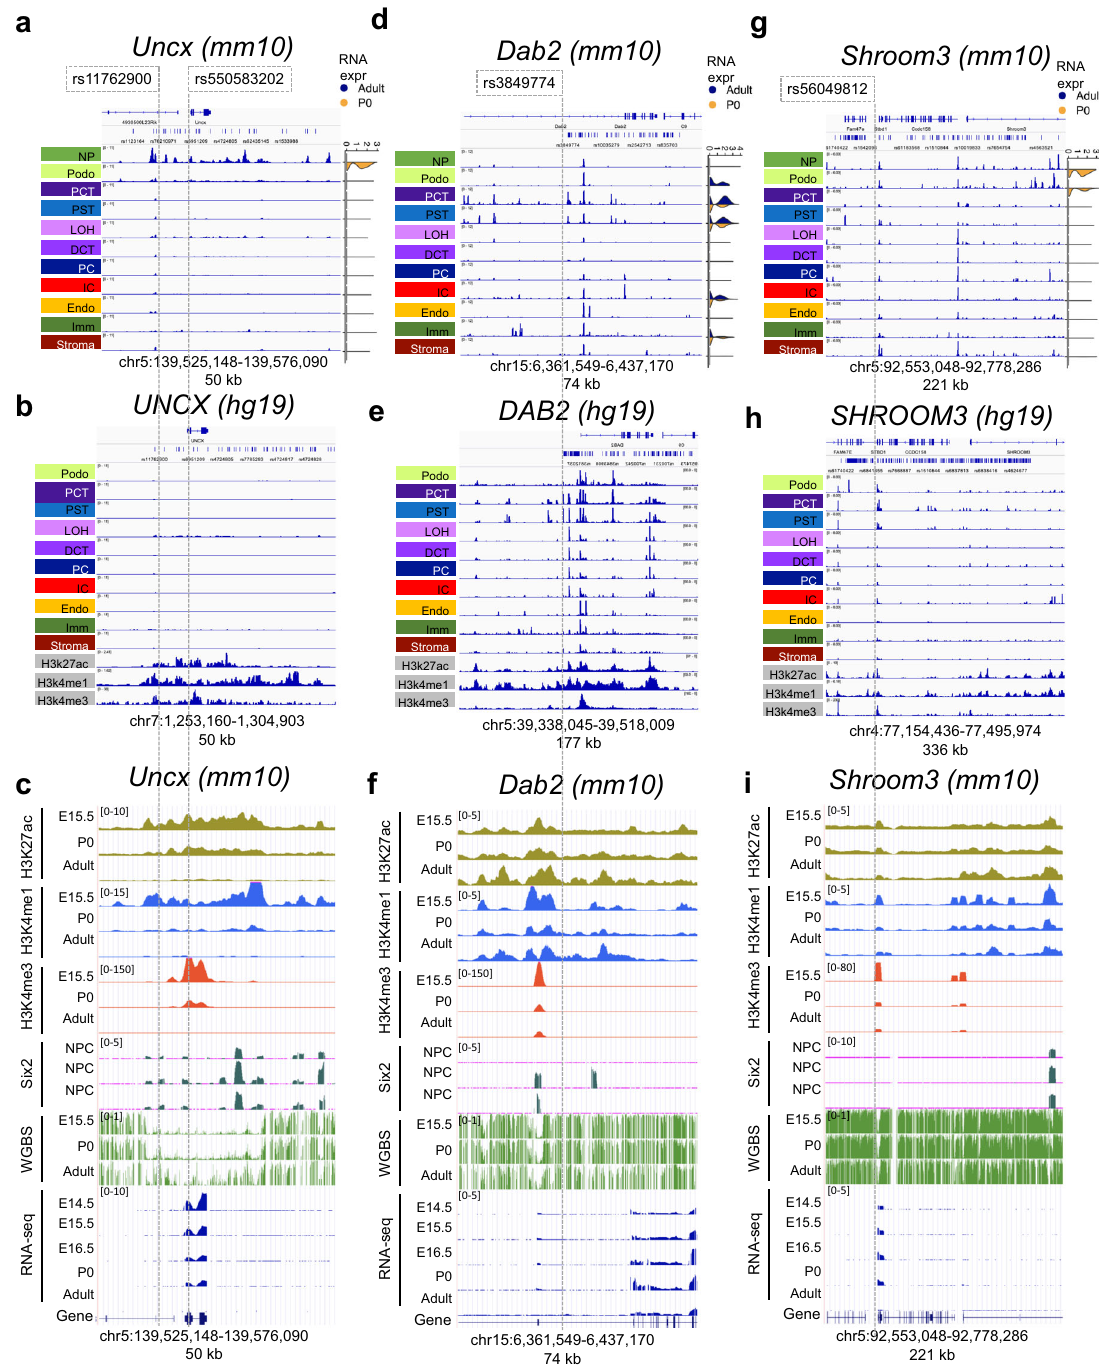
Fig. 6 Single cell level chromatin accessibility highlighted human kidney GWAS target genes and cell types. a , d , g Genome browser view of Shroom3 , Dab2 , and Uncx loci; from top to bottom: mouse orthologue of eGFR GWAS signi fi cant SNPs (after lift-over) mouse kidney single nuclei chromatin accessibility for nephron progenitors (NP), podocytes (Podo), proximal convoluted and straight tubules (PCT and PST), loop of Henle (LOH), distal convoluted tubule (DCT), collecting duct intercalated cells (IC), collecting duct principal cell types (PC), endothelial cells (Endo), immune cells (Immune) and stromal cells (Stroma). Data range in all tracks is set to the same scale. Examples of cell type-speci fi c accessible chromatin overlapped with signi fi cant SNPs are highlighted with dashed lines. Right subpanel shows violin plots of cell type-speci fi c gene expression in P0 (orange) and adult (blue) kidneys in the scRNA-seq dataset. b , e , h Corresponding genome browser views in adult human (hg19) kidney snATAC-seq data; from top to bottom: eGFR GWAS signi fi cant SNPs, adult human kidney single nuclei chromatin accessible landscape, whole kidney H3K27ac, H3K4me1, and H3K4me3 ChIP-seq tracks. The genomic location in human was matched to the mouse orthologue. Note that for DAB2 ( f ), the image was mirrored to facilitate comparison along genomic read direction. Alternative genome browser views at more zoomed-in locations are available in Supplementary Fig. 23. c , f , i Whole mouse kidney epigenomics tracks from E14.5, E15.5, E16.5, P0, and adult mice. From top to bottom: H3K27ac, H3K4me1, H3K4me3, and Six2 ChIP-seq; whole genome bisulfate sequencing (WGBS); and bulk RNA-seq. The bottom Refseq visualization corresponds to the Refseq track at the top in a , d , g , respectively. Six2 binding signal in nephron progenitor